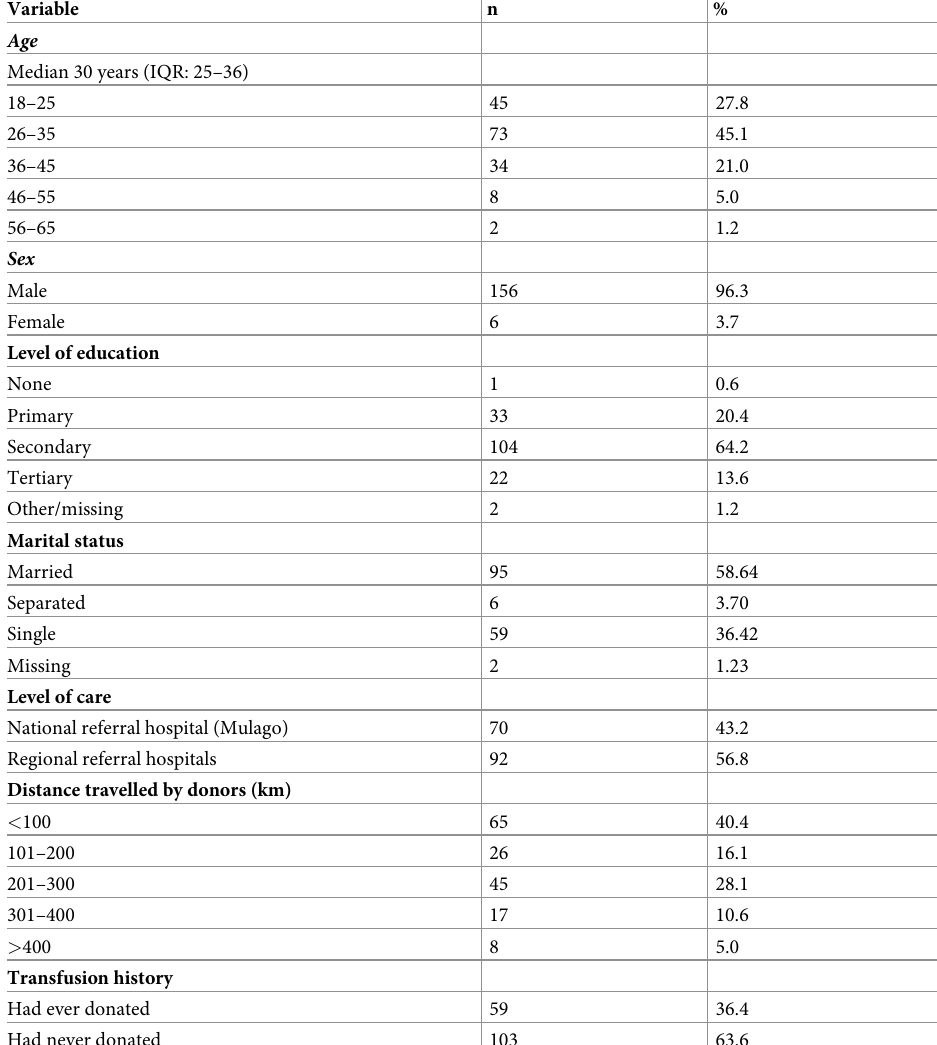
Table 1. Characteristics of the donors (N =